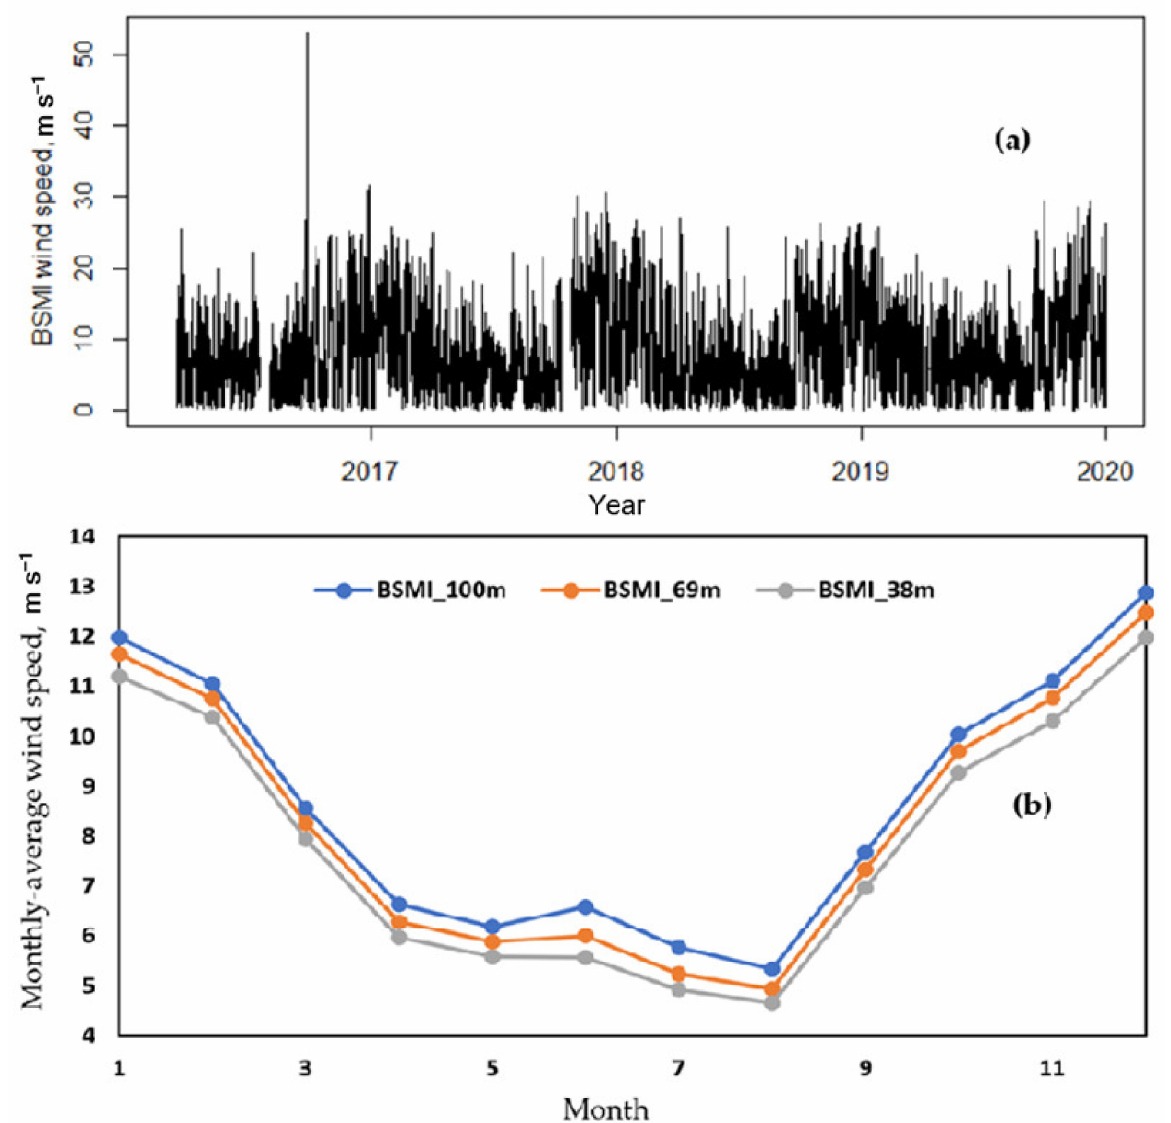
Figure 3. ( a ) Time series plot of the 10 min average BSMI wind speed at 100 m height. ( b ) Monthly wind speed at different